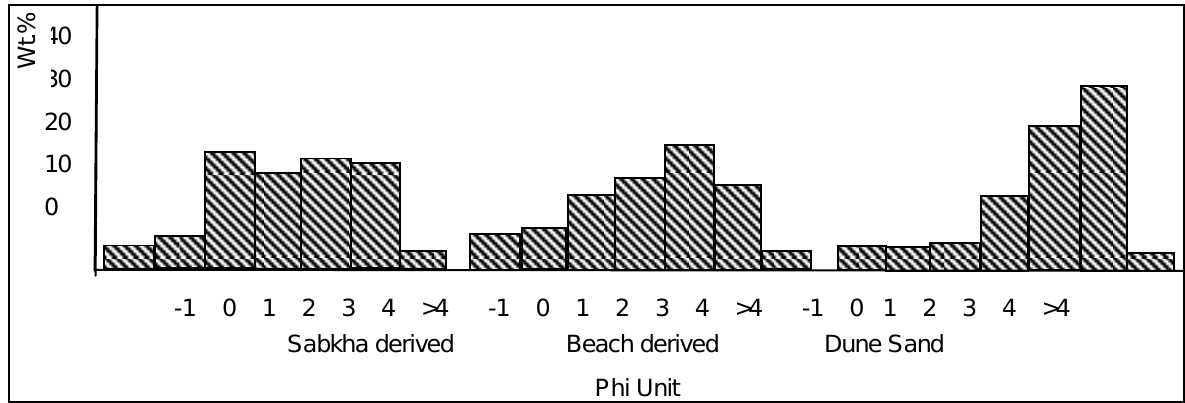
Figure 9. Average of grain size analyses of the three sand